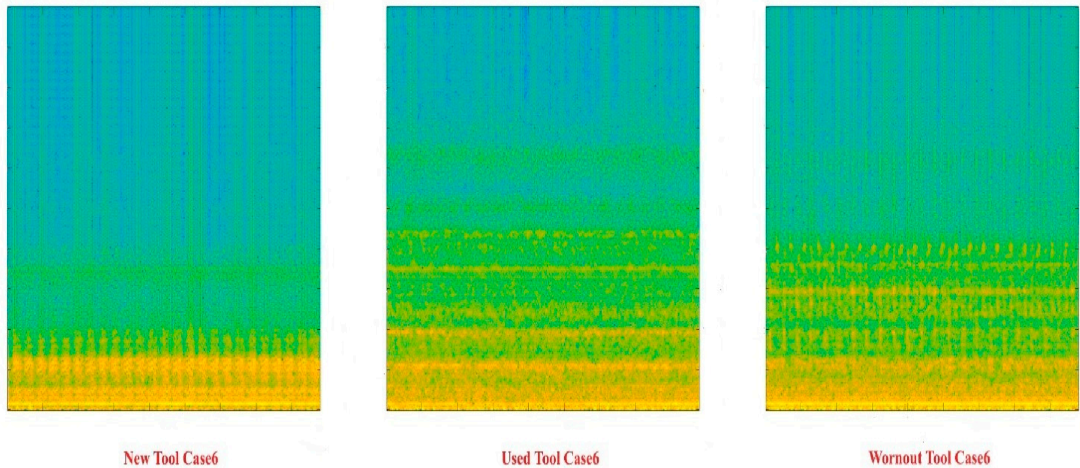
Figure 27. Spectrograms (training samples) of new, used, and worn-out tool conditions for Case